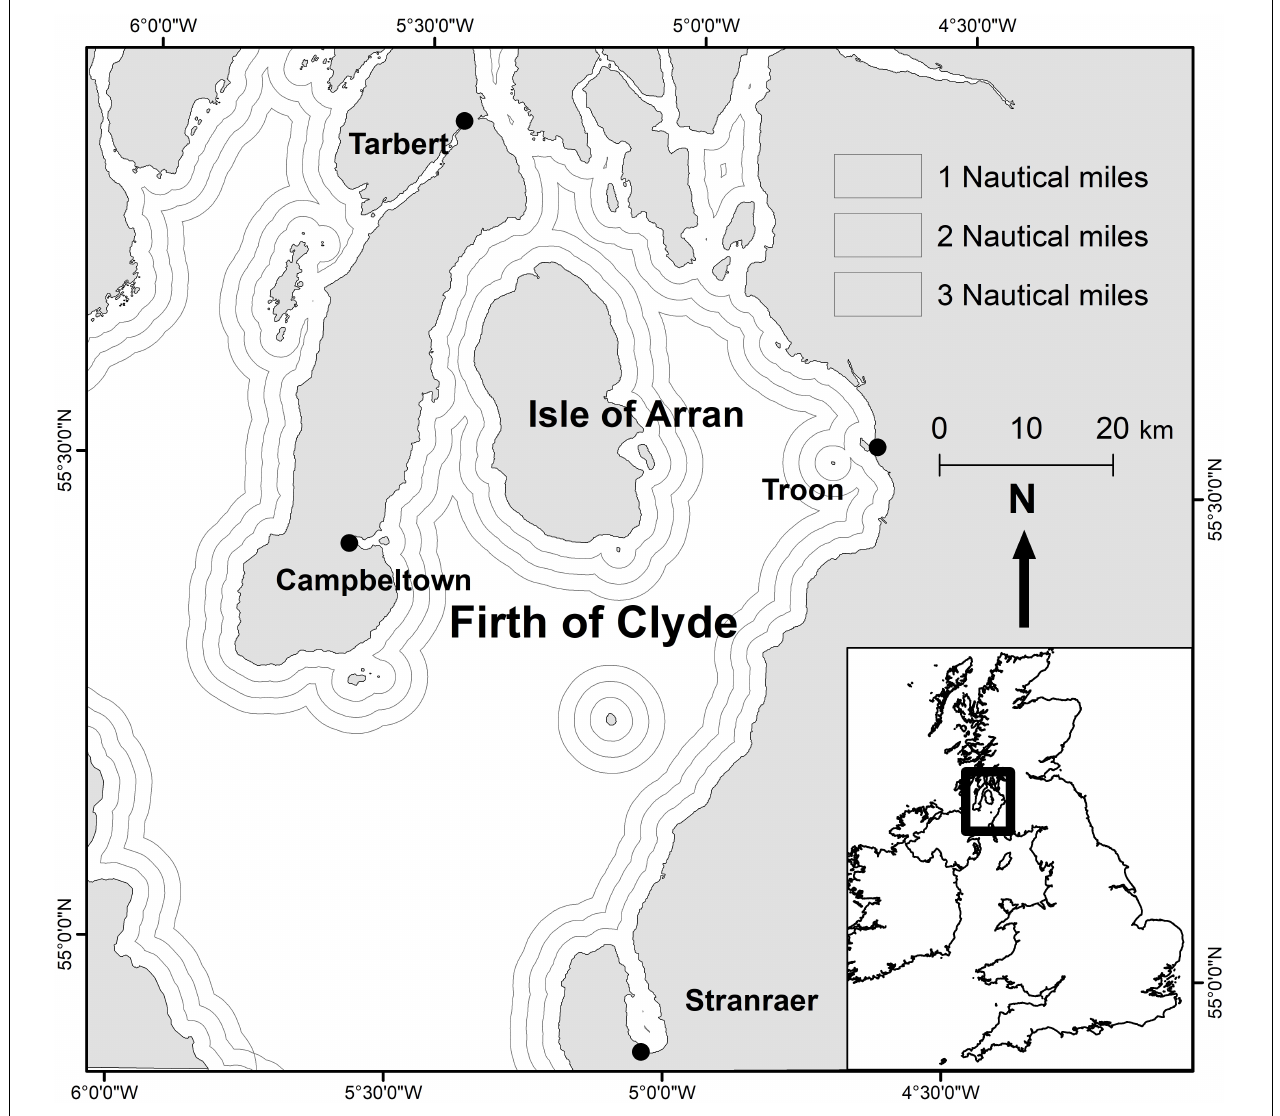
FIGURE 1 | Location of the Isle of Arran in the middle of the Firth of Clyde, Scotland. Inset shows the location of the Clyde within the United